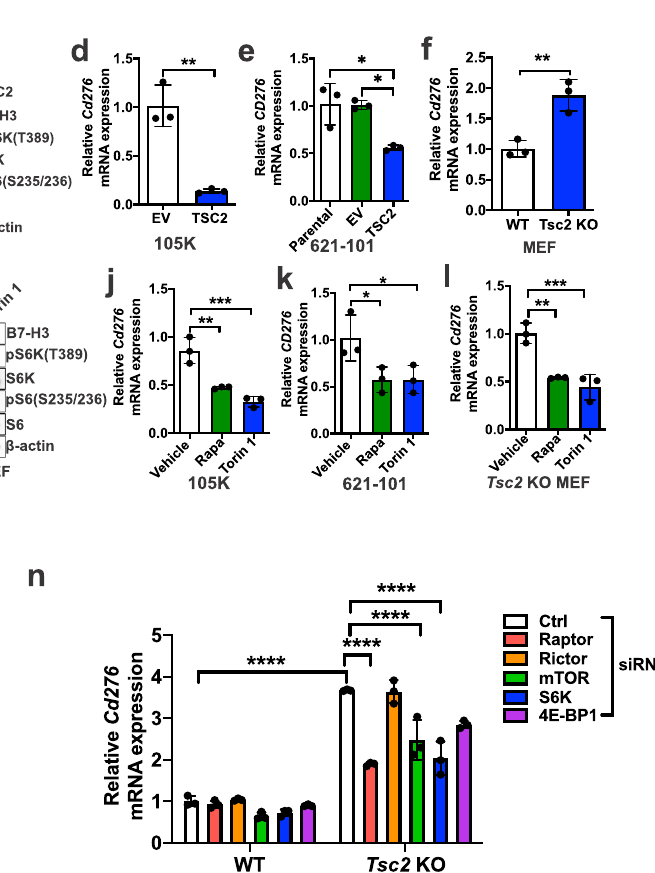
Fig. 2 | B7-H3 expression is regulated by mTORC1. B7-H3 protein expression in Tsc2 − / − 105K cells with stable reconstitution of TSC2 or empty vector (EV) ( a ), TSC2 − / − 621-101 angiomyolipoma-derived cells with reconstitution of TSC2 or empty vector (EV) ( b ), and Tsc2 -WT and Tsc2 KO MEFs ( c ). For all fi gure legends, n =3indicatesrepresentativeof3biologicsamples( n =3).B7-H3mRNAexpression in Tsc2 − / − 105K cells with stable reconstitution of TSC2 or empty vector (EV) ( d ), TSC2 − / − 621-101angiomyolipomatumorcellswithreconstitutionofTSC2orempty vector (EV) ( e ), Tsc2 -WT and Tsc2 KO MEFs ( f ). Means ± SD, two-tailed unpaired Student ’ s t -test ( d , f ) or one-way ANOVA with Dunnett ’ s multiple comparisons test ( e ), * p < 0.05, ** p <0.01. n =3. B7-H3 protein expression in Tsc2 − / − 105K cells ( g ), TSC2 − / − 621-101angiomyolipomatumorcells( h ),and Tsc2 KOMEFs( i )treatedwith 20nM rapamycin (Rapa), 500nM Torin 1 or vehicle for 24hr ( n =3). B7-H3 mRNA